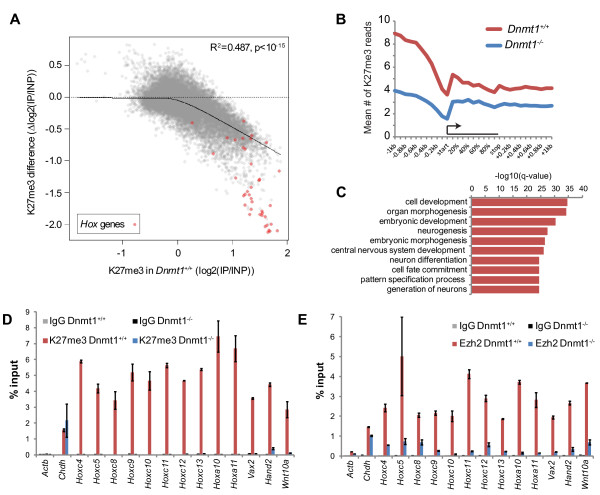
H3K27me3 is lost from Polycomb target gene promoters in DNA hypomethylated somatic cells. (A) Scatter plot showing the relationship between H3K27me3 enrichment in Dnmt1+/+ MEFs (x-axis) and the difference in H3K27me3 enrichments between Dnmt1+/+ and Dnmt1-/- MEFs (y-axis) at all promoter regions by ChIP-chip. A llocally weighted scatterplot smoothing line (black) is plotted. The R2 value (Pearson's) is shown alongside the P-value from a Pearson's correlation test. Hox gene promoters are plotted as red points. (B) H3K27me3 ChIP-seq data for regions surrounding Polycomb target genes. Polycomb target genes were defined as the top 10% of gene promoters as ranked by H3K27me3 enrichment (by ChIP-chip) in Dnmt1+/+ MEFs. (C) Top 10 Gene Ontology terms (Biological Process) found to be significantly enriched among H3K27me3 down genes using all genes covered on the microarray as background. The q-value for enrichment of each term is plotted as -log10(q-value). (D, E) ChIP-qPCR for H3K27me3 (D) and Ezh2 (E) in Dnmt1+/+ and Dnmt1-/- MEFs using primers for the promoters of the indicated genes. Enrichment for each immunoprecipitation (IP) is expressed as percentage of DNA in input. Non-specific IgG IP and the Actb promoter are shown as negative controls and the Chdh promoter is shown as a positive control. Error bars indicate ± standard error of the mean of two experiments.